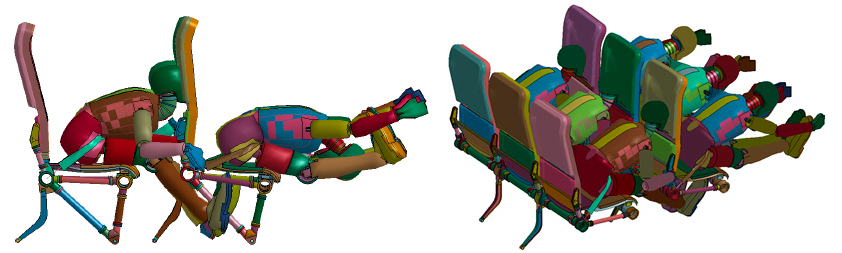
Figure 12. Kinematical response of crash test 3.